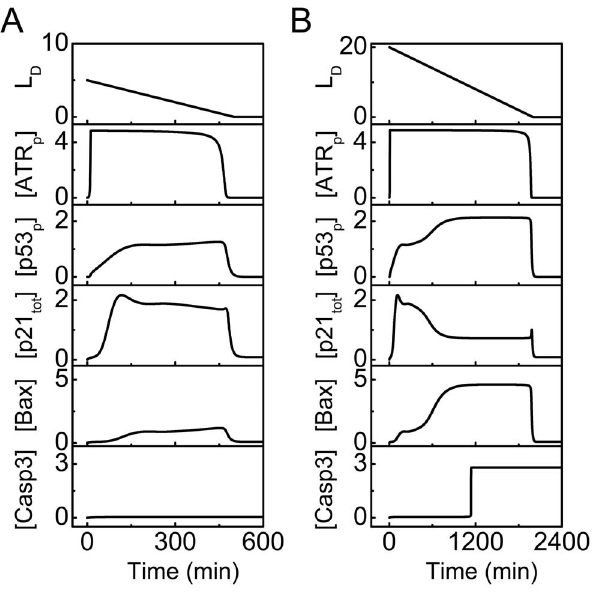
Figure 2. Dynamics of key components of the p53 network. Temporal evolution of the levels of DNA damage, ATR p , p53 p , p21 tot , Bax, and Casp3 (from top to bottom) at L D0 ~ 5 (A) or 20 (B).